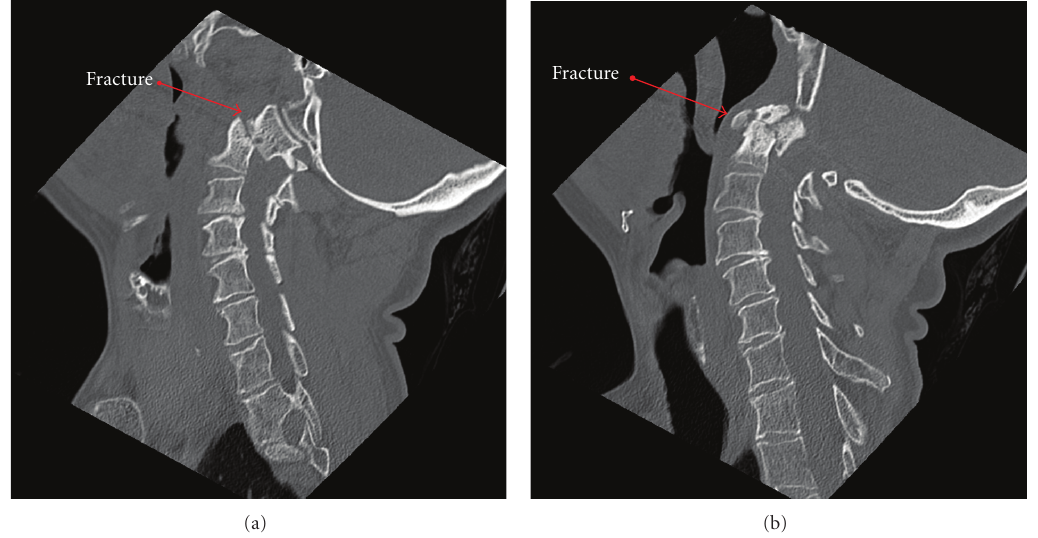
Figure 2: It shows noncontrasted MRI with cervical spine